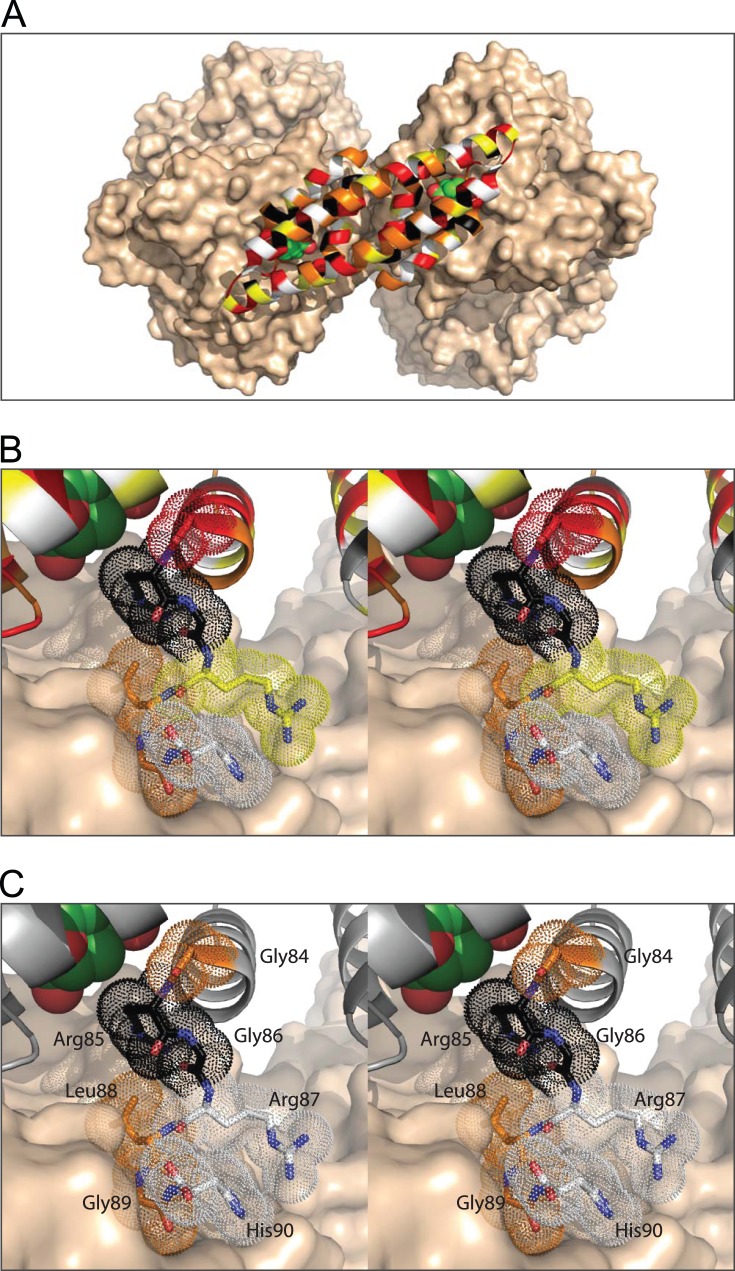
Comparison of phylogenetic and experimental amino acid conservation patterns at the interface between MtCM and MtDS.Conservation patterns in MtCM are illustrated with the crystal structure of the MtCM-MtDS complex (PDB: 2W1A). The color code for individual residues indicates the level of sequence conservation (black, 100%; red, ≥75%; orange, ≥50%; yellow, ≥33%; white, <33% identity). (A) Overview with MtCM positions colored as in the phylogenetic alignment in Fig. 3B. MtDS is shown in wheat surface representation, MtCM in cartoon mode. Fully conserved residues (black) are generally clustered around the active site with bound 7 (shown as space-filling model with green carbons), whereas the solvent-exposed residues typically show low conservation (white and yellow). (B, C) Wall-eyed stereogram of a close-up of the contact area between the C-terminal region of MtCM and MtDS, with ligand 7 depicted in the top left corner as in (A). The C-terminal loop hooks onto the MtDS surface. In (B), the phylogenetic color coding as in (A) is used for the segment from positions 84–90, which is highlighted with dotted spheres for the individual side chains. In (C), the color coding for the same segment represents the conservation pattern found by experiment in selected MtCM variants in the presence of MtDS.